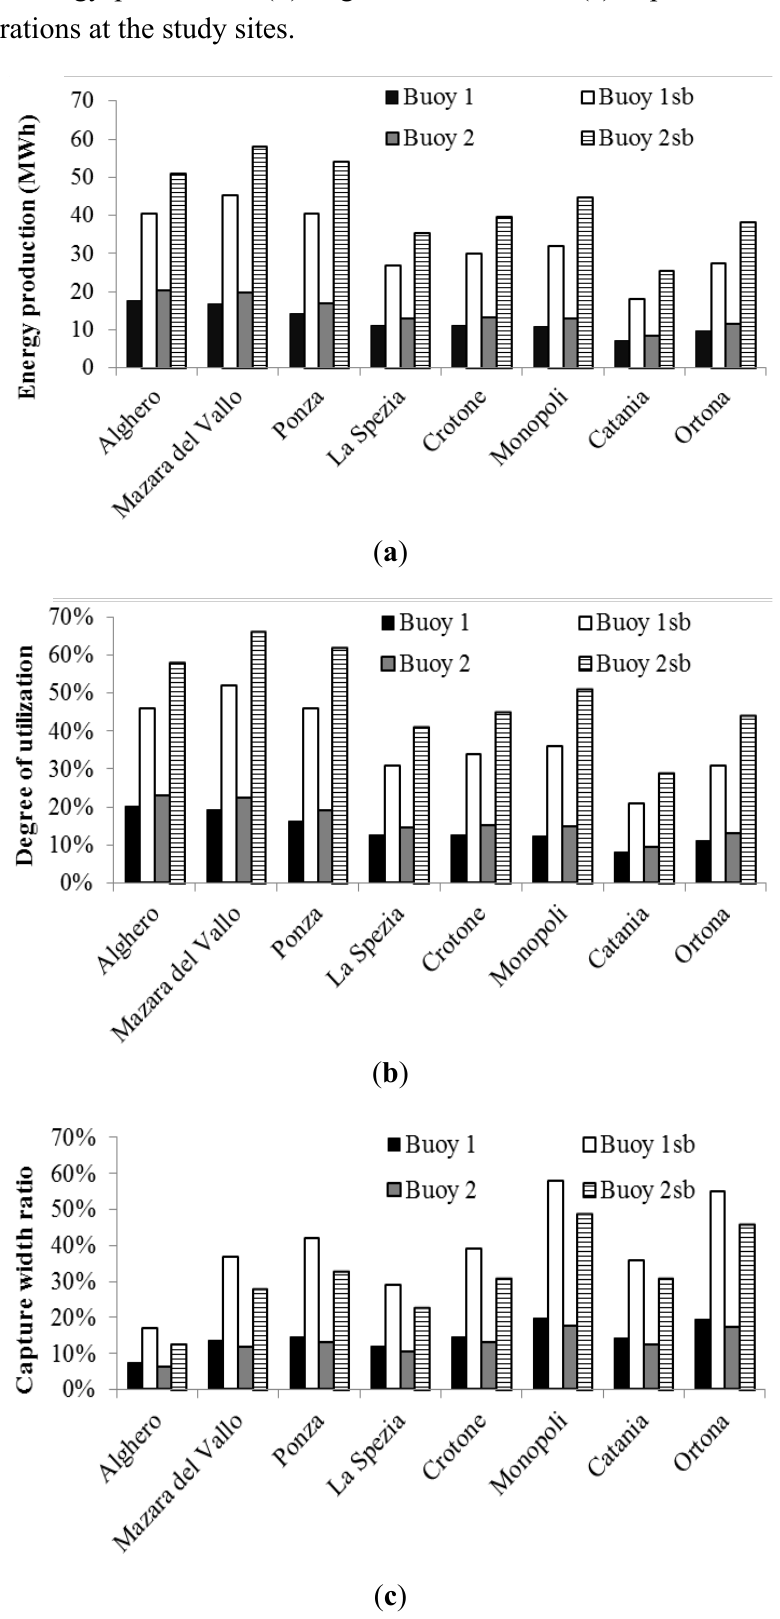
Figure 6. ( a ) Energy production; ( b ) degree of utilization; ( c ) capture width ratio of the buoy configurations at the study